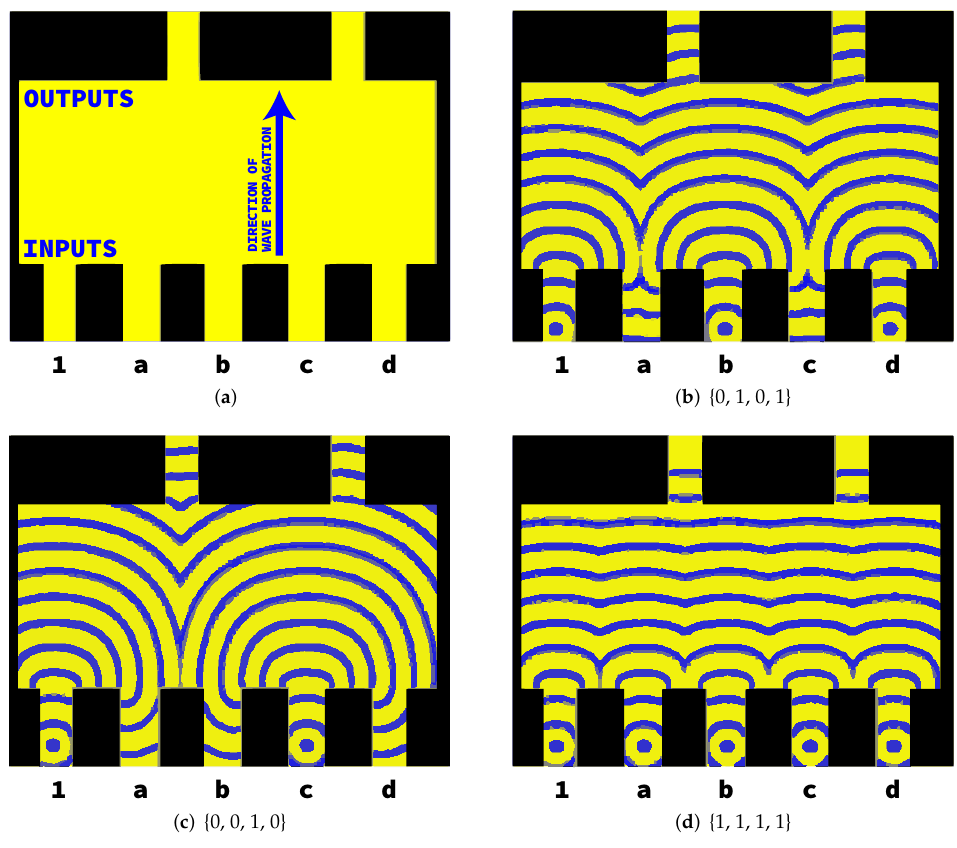
Figure 3. ( a ) Combinatorial logic gate [( a OR b ) AND ( c OR d )] topology as proposed in [23]. ( b – d ) Chemical waves propagation for different input combinations { a , b , c , d }